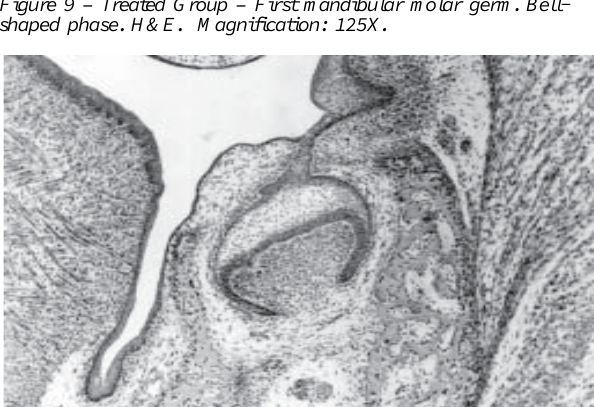
Figure10 – Treated Group – First mandibular molar germ. Cap phase. H&E.